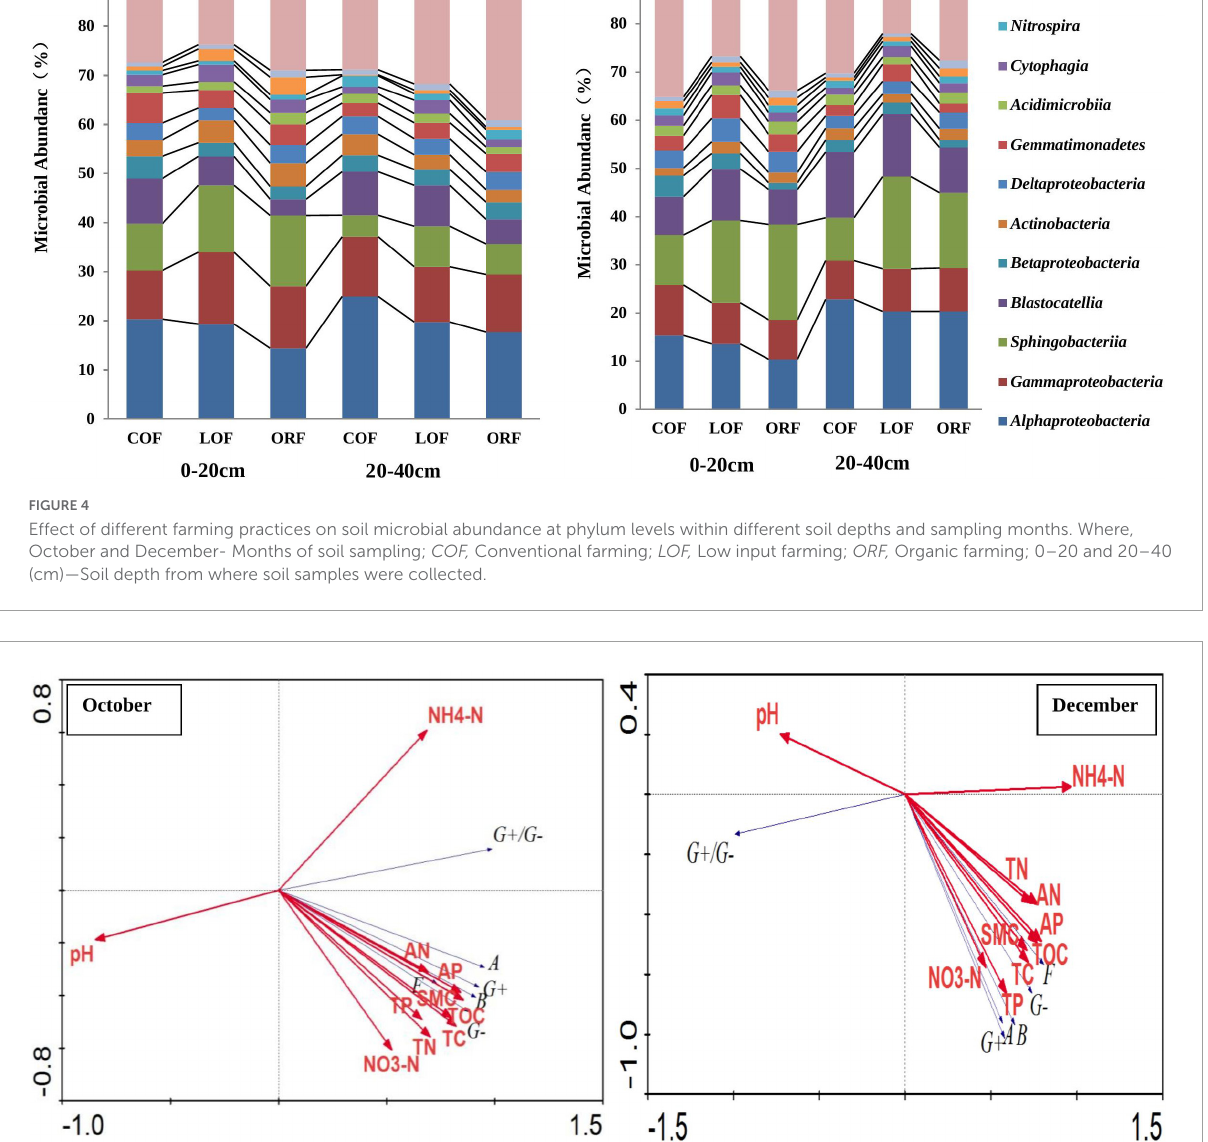
was observed to be negatively correlated with soil pH at the significance level of at p ≤ 0.05. Presence of Cytophagia was negatively correlated with soil pH and Shannon index at p ≤ 0.01 whereas Nitrospira was found positively correlated